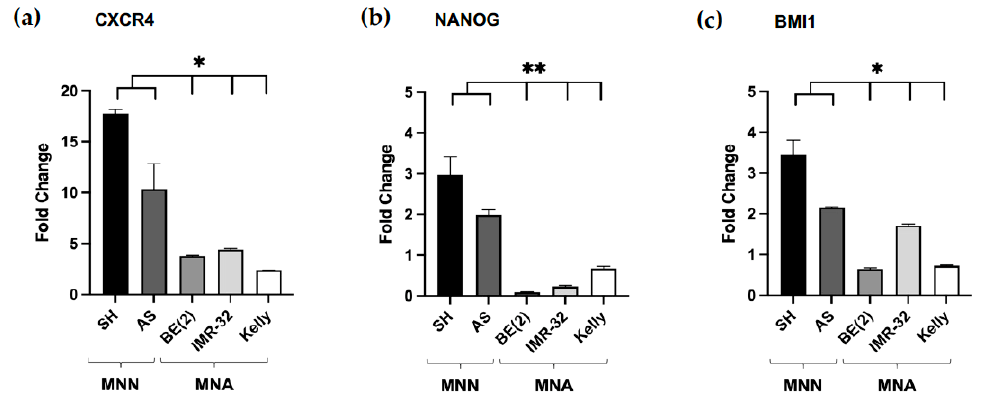
Figure 3. CSC-like marker expression in neuroblastoma spheroids compared to monolayer cell cultures. Fold change increase in cancer stem cell (CSC)-like marker ( a ) CXCR4, ( b ) NANOG and ( c ) BMI1 expression in spheroids compared to monolayer cultures of neuroblastoma cell lines SK-N- SH (SH), SK-N-AS (AS), SK-N-BE(2) (BE(2)), IMR-32 and Kelly determined by RTqPCR. Normalized